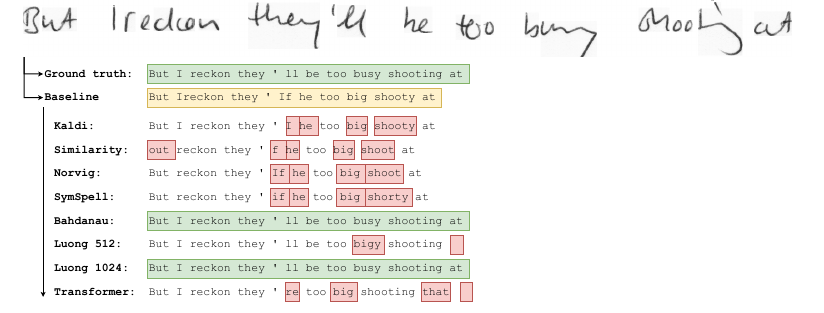
Figure 15. Correction sample in IAM